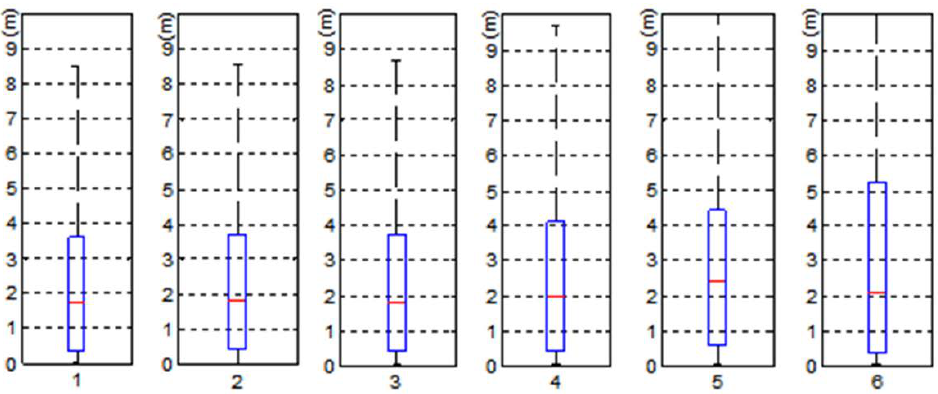
Figure 8. Boxplots of the LoD parameters based on the leaf bends of the six curves (after removing the outliers). Table 4. LoDs for the 50 contour lines and the consistency of the nominal scale and actual